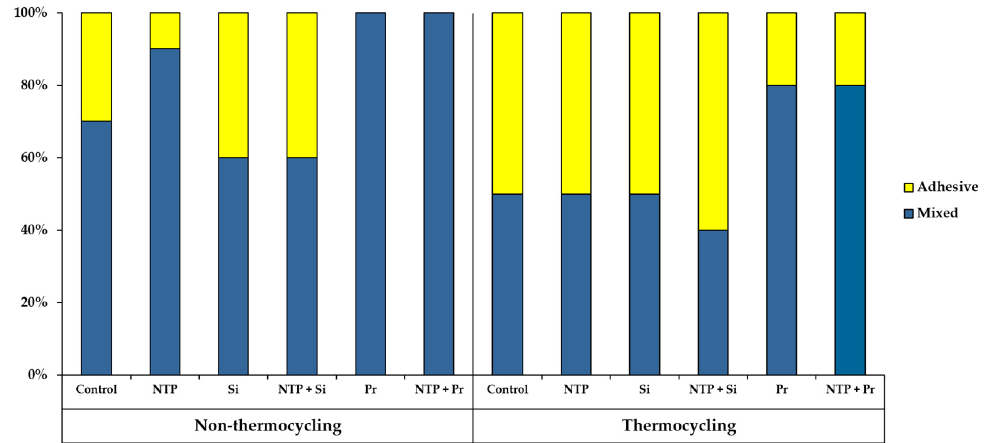
Figure 10. Failure mode between the zirconia crown and the resin cement in all groups after RS test. Adhesive failure between the titanium abutment and the resin cement, as well as cohesive failure in the resin cement, did not occur in any group.